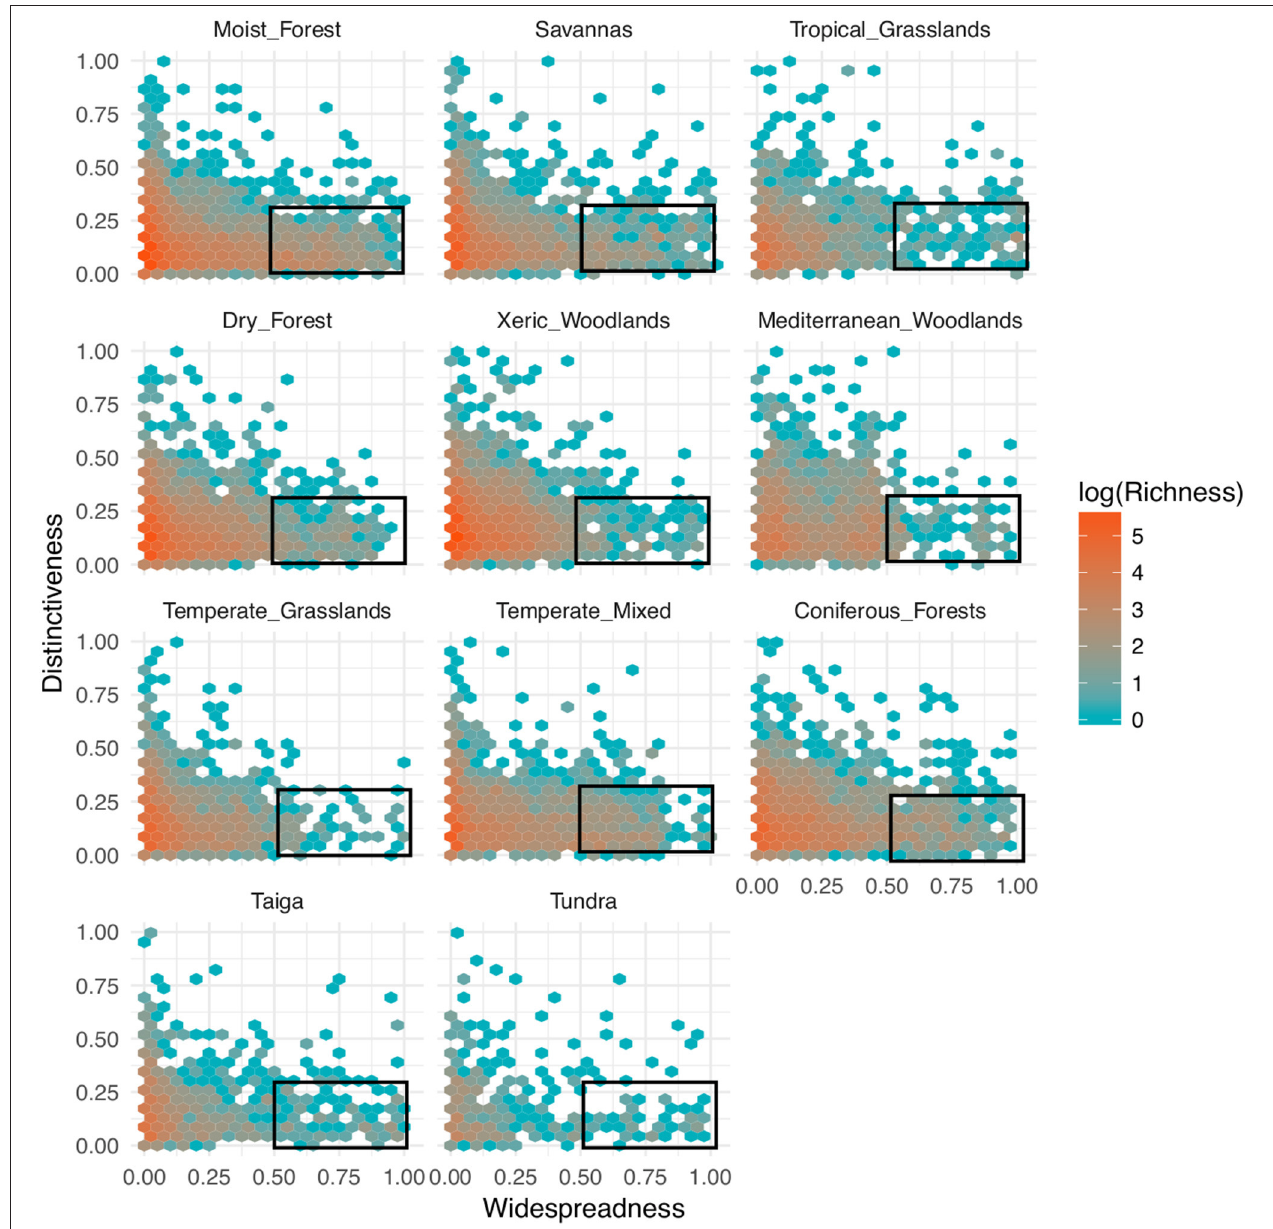
FIGURE 3 | Patterns of functional distinctiveness across biomes. Distinctiveness represents how species are functionally distant from each other within a biome (i.e., the mean pairwise phenotypic distance from a focal species to all the others). The larger the value, the more distant a species is to the centroid of the biome’s functional space. Widespreadness measures how geographically common a species is within a biome. A value of 0 indicates that a species is present in a single biome cell. Bin values are the number of species on a log e scale. Rectangles represent the species that are considered functionally similar and widespread in each biome using cut-off values of 0.25 and 0.5 of distinctiveness and widespreadness,